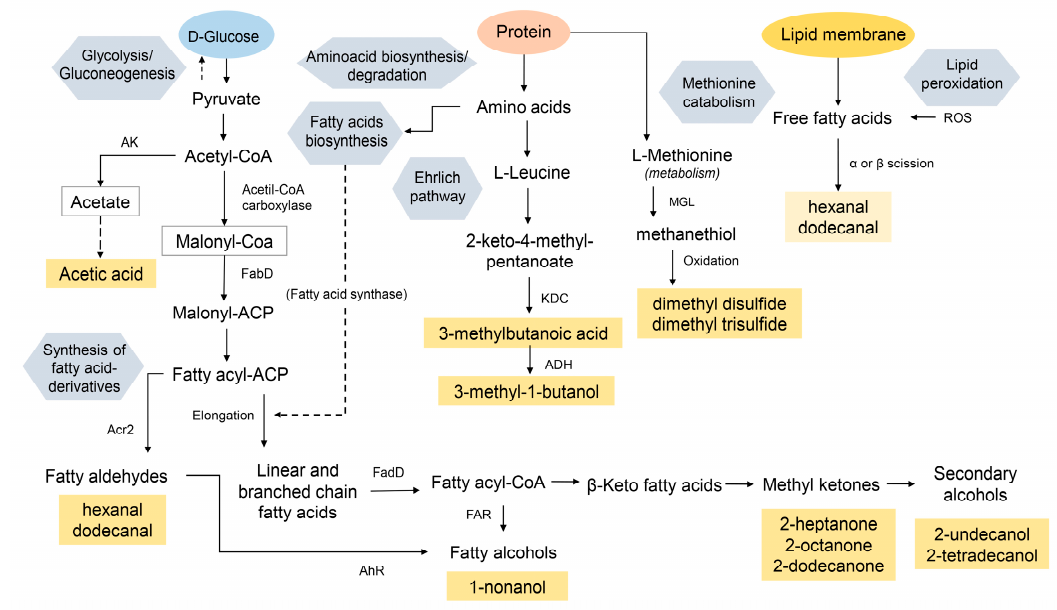
Figure 8. Scheme showing main pathways related to volatile organic metabolites which presented relevant alterations in their responses due to nanoparticles supplementation (AK—acetate kinase;